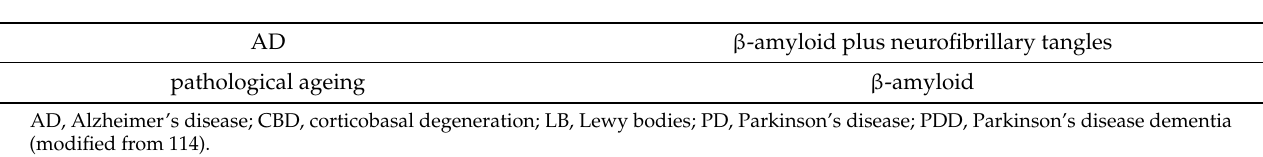
Table 1. Interactions of various pathological proteins and disease.